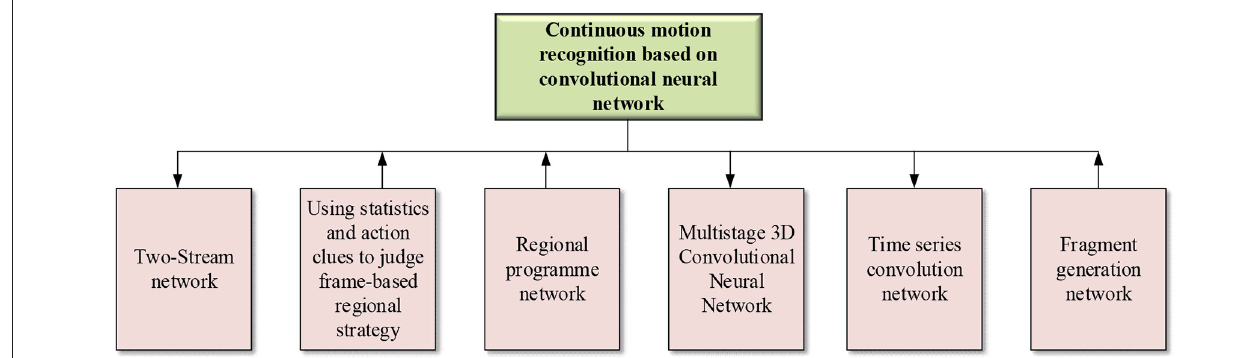
FIGURE 2 | Motion recognition based on CNN.